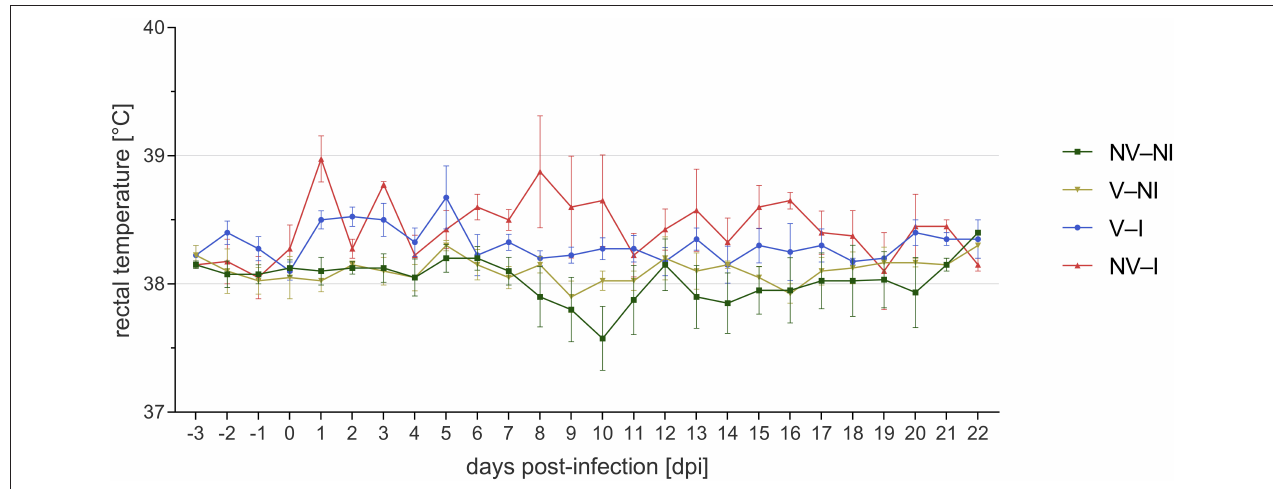
FIGURE 3 | Course of mean rectal temperature and standard error of gilts from the four treatment groups after porcine reproductive and respiratory syndrome virus infection per day post-infection. Gilts 2 and 22 were excluded from visualization. NV–NI, non-vaccinated and non-infected gilts; V–NI, vaccinated and non-infected gilts; V–I, vaccinated and infected gilts; NV–I, non-vaccinated and infected gilts.